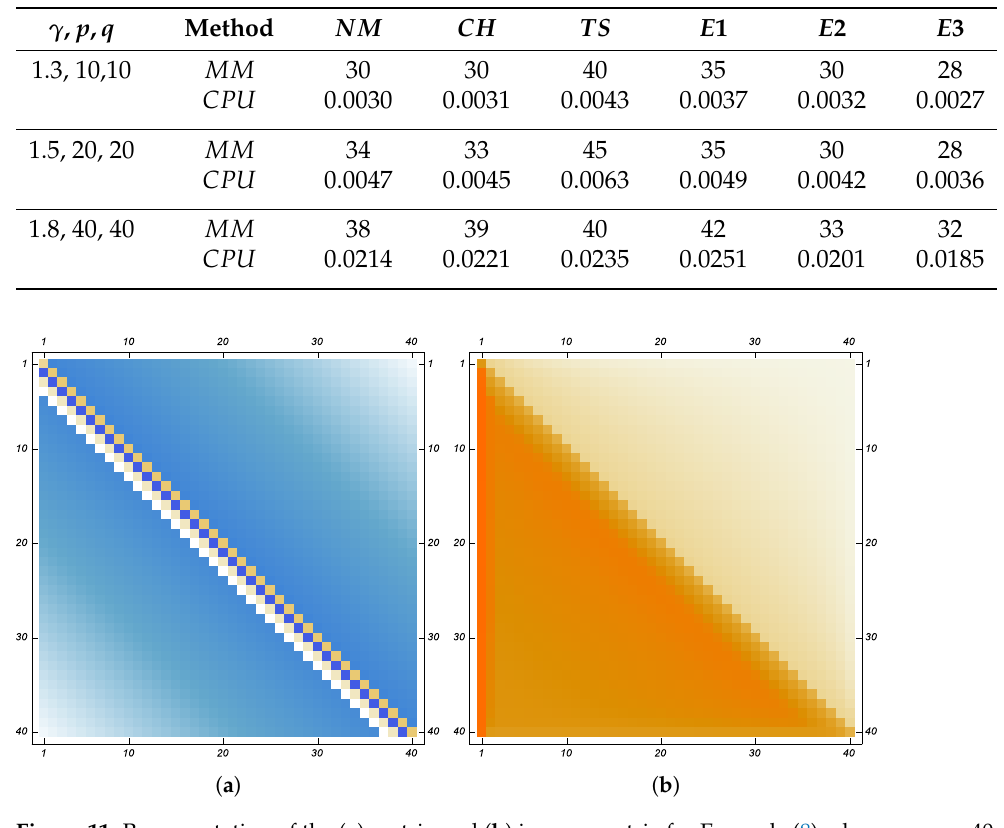
Figure 11. Representation of the ( a ) matrix and ( b ) inverse matrix for Example (8) when p = q = 40,